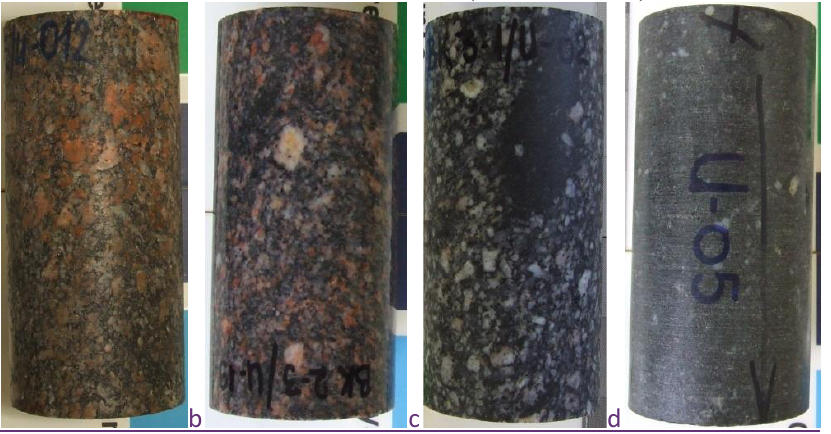
different carbonate rocks (Palchik, 2011)